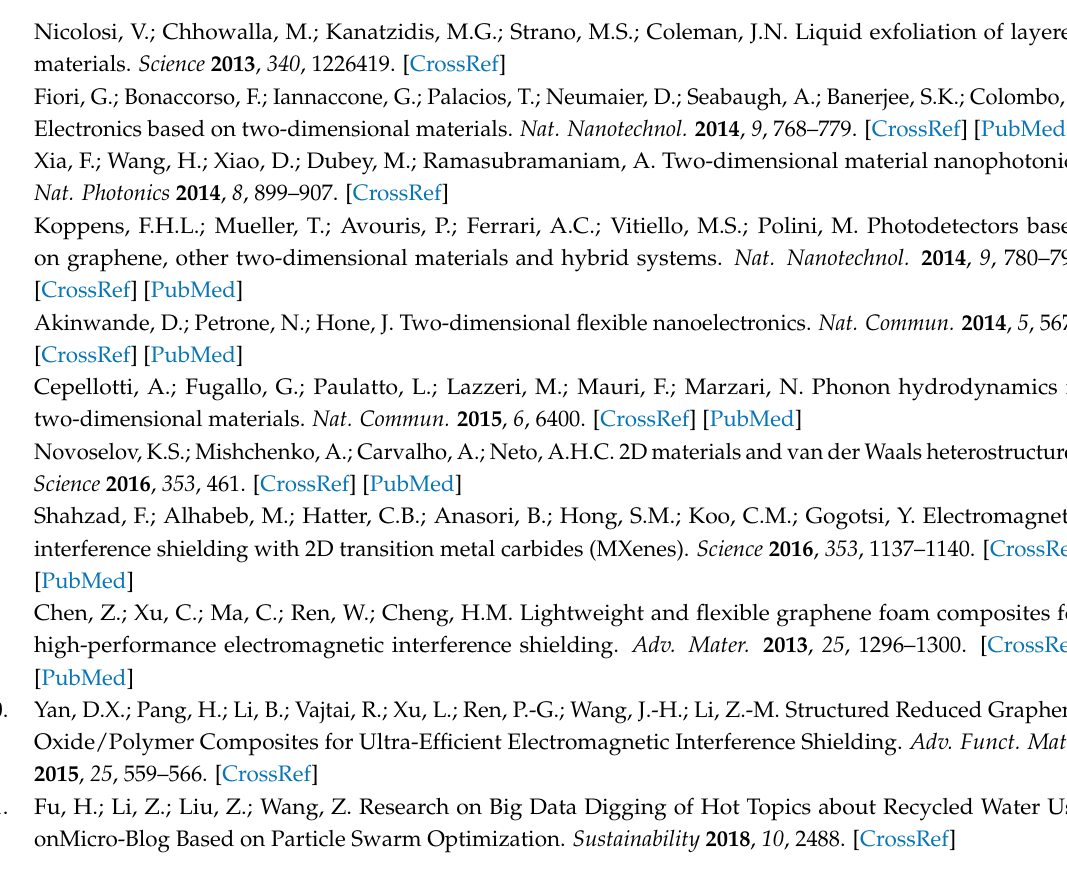
Table S1. Physical parameters for Figures 2a and 4a in main text; Table S2. Physical parameters for Figures 2c and 4b in main text; Table S3. Physical parameters for Figure 3a in main